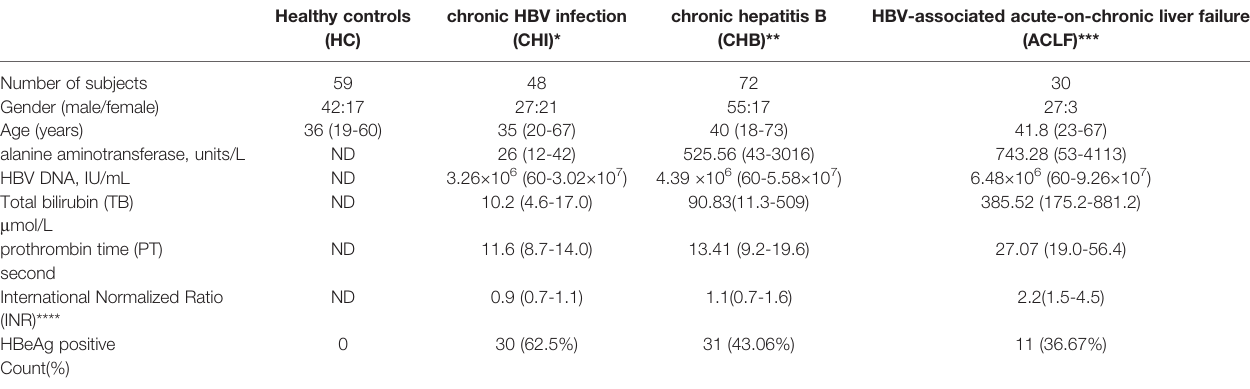
TABLE 1 | Clinical characteristics of patients and